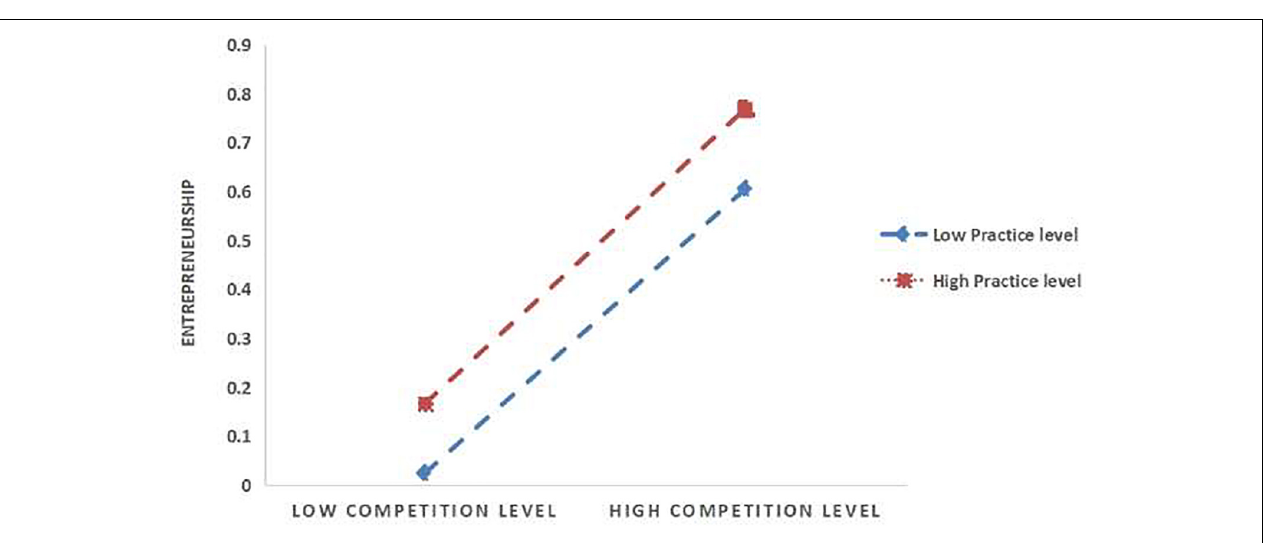
FIGURE 3 | The moderating role of entrepreneurial practice in the relationship between entrepreneurship competition and entrepreneurial